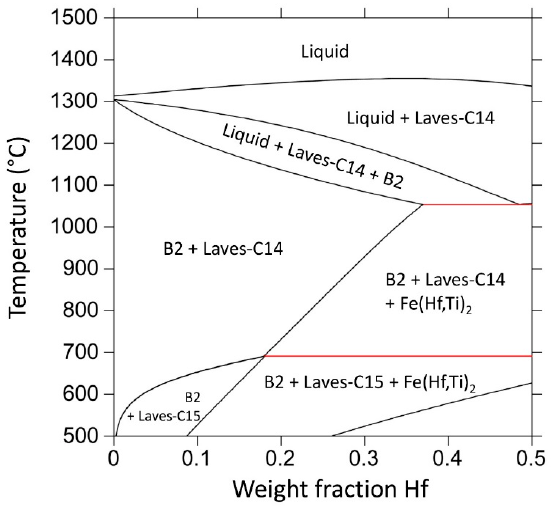
Figure 5. Calculated isopleths for TiFe + x Hf (with x = 0–50 wt.%) showing predicted phases as a function of Hf content and temperature, and in particular the two-phase B2 + Laves-C14 field up to 37 wt.% Hf at 1055 °C.